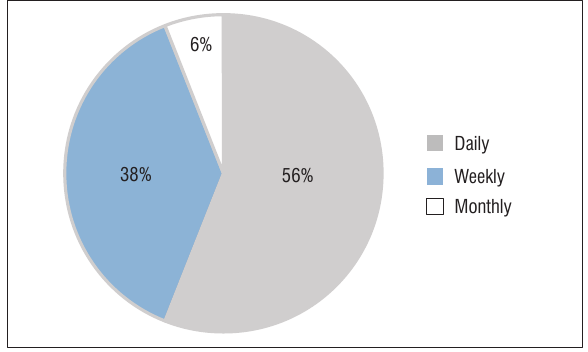
Frequency of user